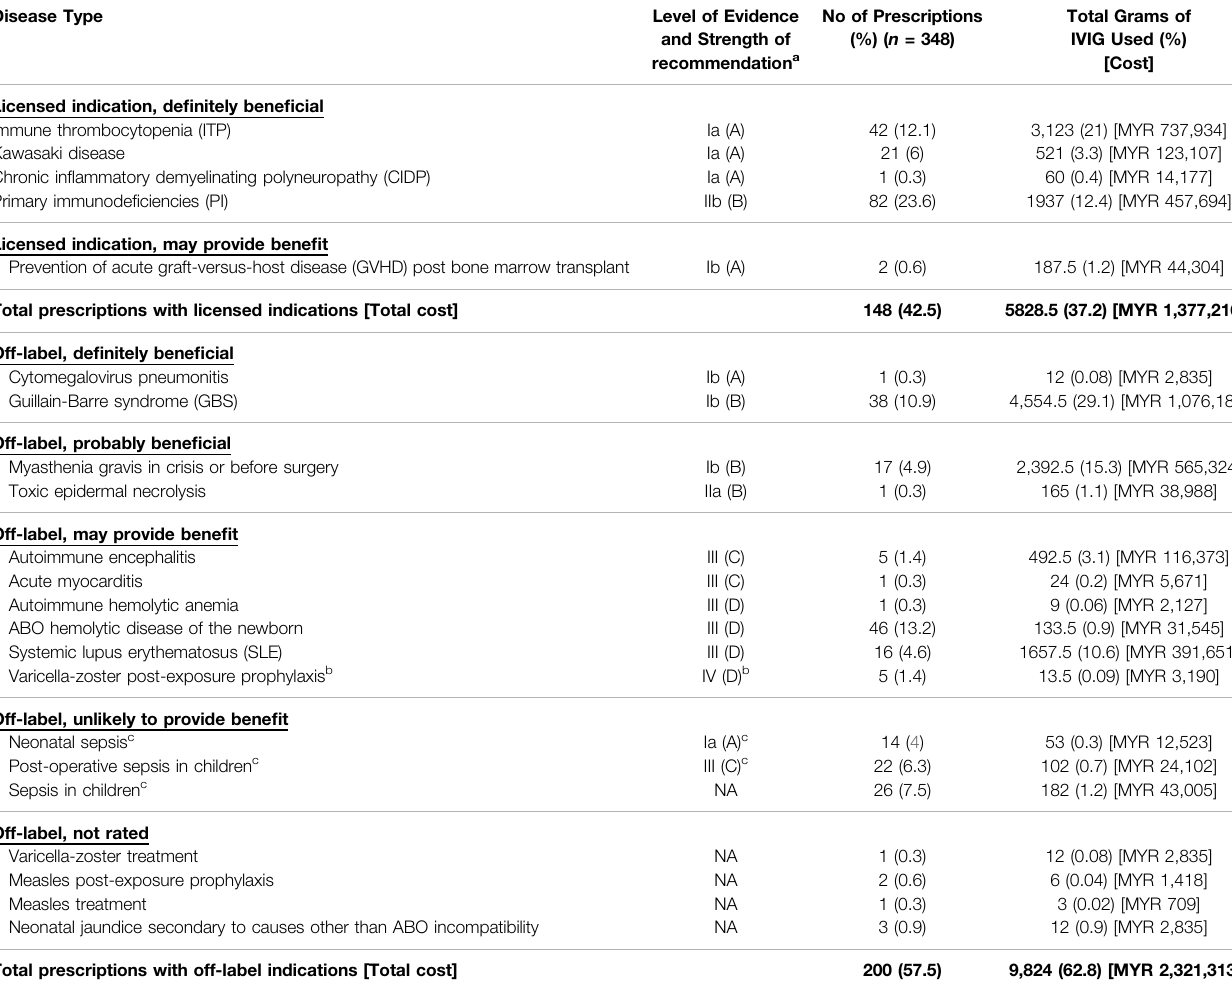
TABLE 2 | Utilization pattern of IVIG according to the level of evidence, the strength of recommendation, and bene fi cial category of treatment. Disease Type Level of Evidence